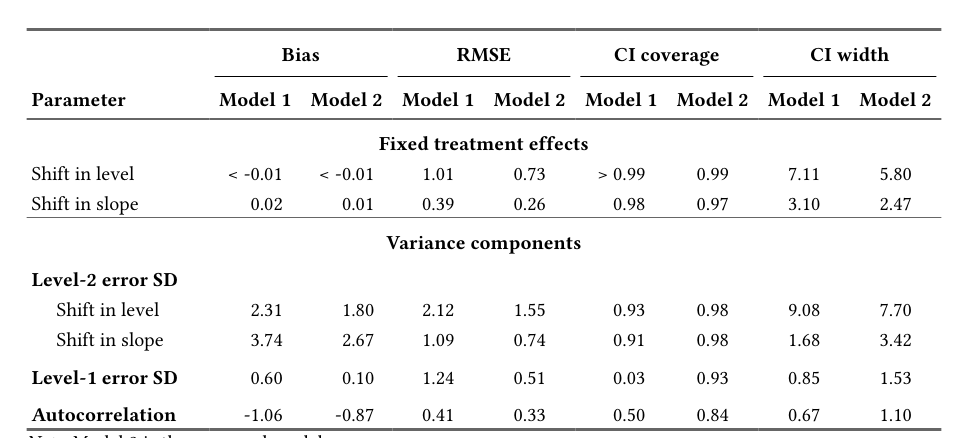
Average Relative Bias, RMSE, Ci Coverage and Width for the Fixed Effects and Variance Components for the Follow-Up Study